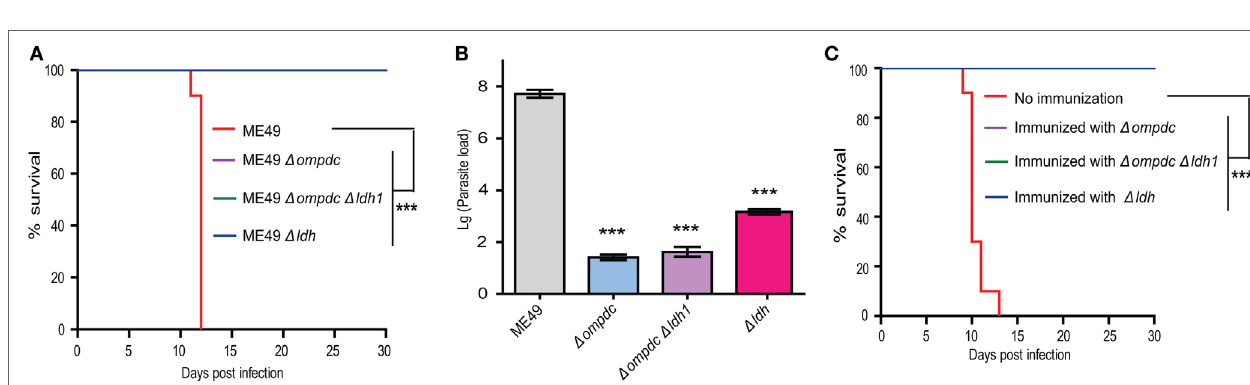
FigUre 10 | Comparison of Δ ldh mutants-based vaccines to that based on Δ ompdc auxotrophs. (a) Survival curves of mice infected with indicated strains. Tachyzoites of indicated strains were used to infect ICR mice (10 4 parasites/mouse, 10 mice for each strain) by intraperitoneal injection and the survival of mice were monitored for 30 days. *** p < 0.001, Gehan–Breslow–Wilcoxon test. (B) Replication of parasites in vivo . ICR mice were infected with 10 4 tachyzoites of indicated strains by intraperitoneal injection and parasite loads in peritoneal fluids 7 days post-infection were determined by quantitative PCR. *** p < 0.001, Student’s t -test. (c) Protection efficiency offered by vaccination of indicated Toxoplasma gondii mutants. ICR mice were immunized with indicated strains by intraperitoneal injection of 10 4 tachyzoites each. Thirty days post-immunization, they were challenged with 10 4 tachyzoites of the ME49 strain and survival of mice were monitored for another 30 days. Non-immunized mice were included as negative control. *** p < 0.001, Gehan–Breslow–Wilcoxon test.